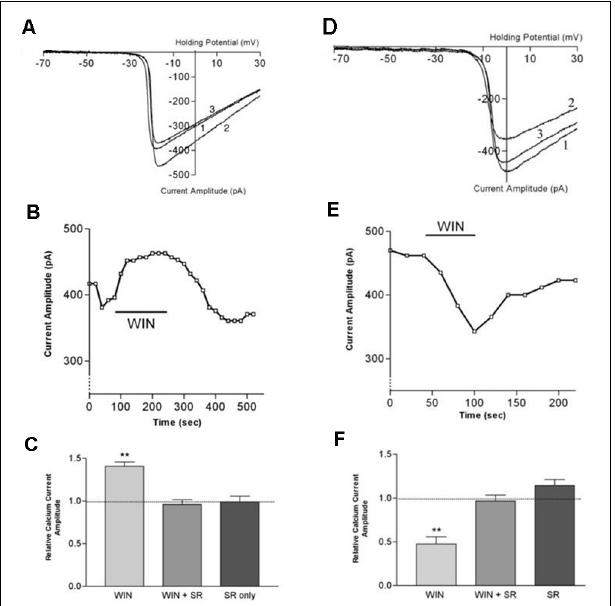
FIGURE 8 | CB1 receptor activation differentially affects ICa in rod vs. cone photoreceptors. (A) I Ca –V curves before application of WIN 55,212-2 (WIN, 1), after application (2), and after wash (3). (B) Peak amplitude of the calcium currents from the same cell over time, indicating a robust enhancement followed by gradual recovery. (C) Summary of results with WIN alone, WIN combined with the selective CB1 receptor antagonist SR141716A and SR 141716A alone. (D) I Ca –V curves before application of WIN 55,212-2 (1), after application (2), and after wash (3). (E) Peak amplitude of the calcium currents from the same cell over time indicating a robust inhibition followed by gradual recovery. (F) Summary of results with WIN alone, WIN plus the selective CB1 receptor antagonist SR141716A, and SR 141716A alone. ** P < 0.01, Student’s t -test. Adapted from Straiker and Sullivan